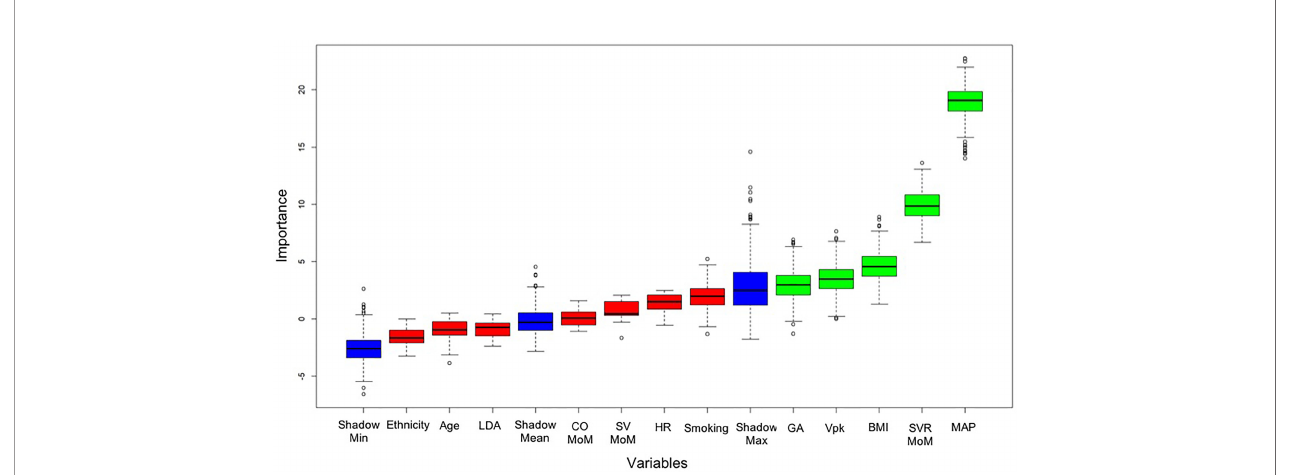
FIGURE 1 | Classi fi catory analysis of FGR phenotypes. Important variables identi fi ed by the Boruta algorithm in the comparison between HDP-FGR and i-FGR cases. In decreasing order of importance, the Boruta algorithm identi fi ed MAP, SVR MoM, BMI, Vpk, and GA at diagnosis of FGR as the most important features with a discriminatory ability between the two FGR